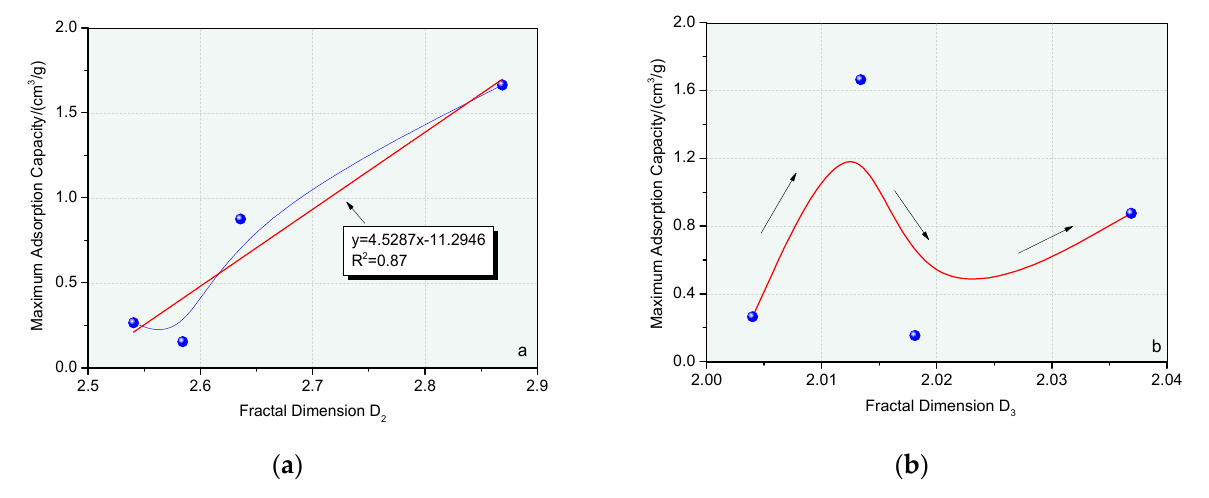
Figure 9. Relationships between fractal dimensions and the maximum adsorption properties. ( a ) D 2 -maximum adsorption capacity. ( b ) D 3 -maximum adsorption capacity.